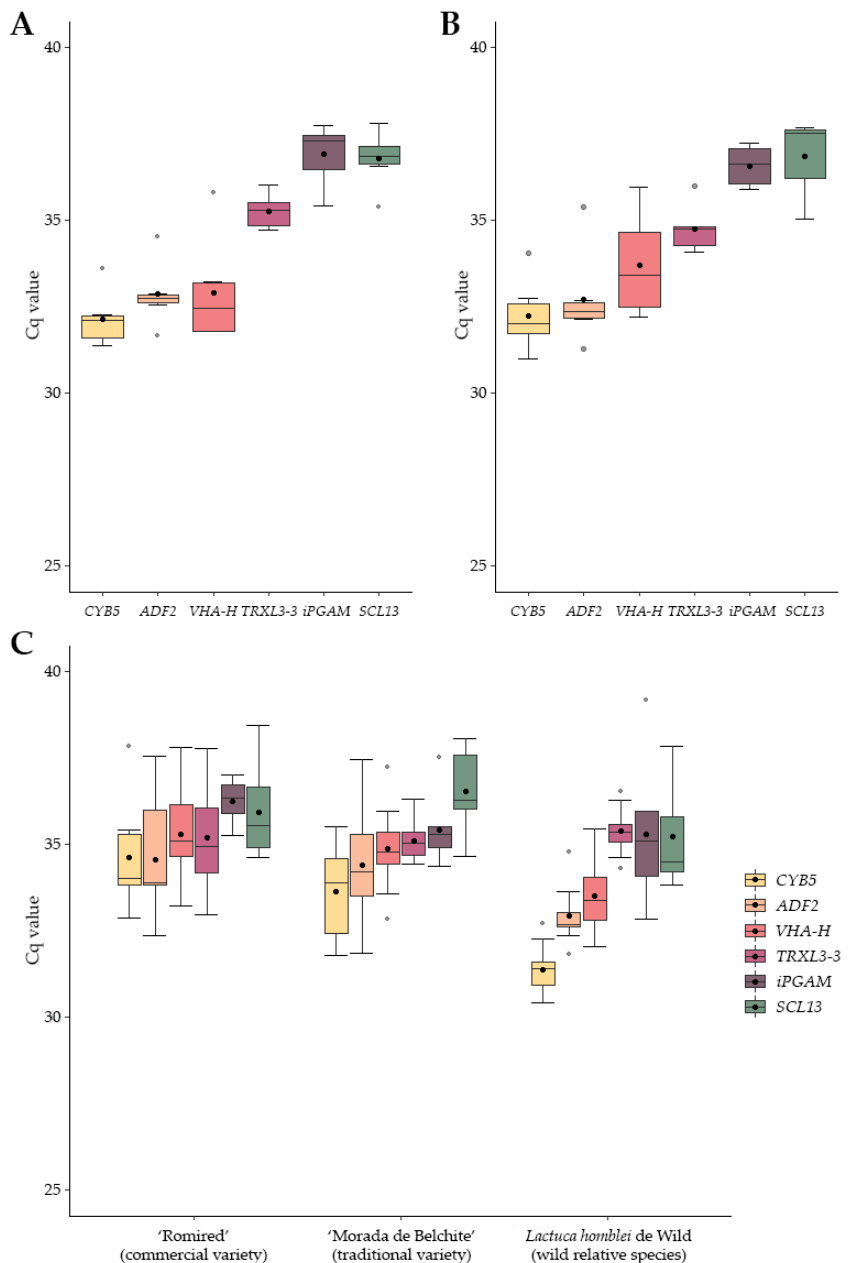
Figure 1. Expression levels, Cq (quantification cycle) values assessed by real-time qPCR (quantitative PCR), of six tested candidate RGs across the samples in three experiments: ( A ) comparison of leaf colour in green and red lettuce commercial varieties; ( B ) comparison of tissues (leaf and stem) in a wild relative species; and ( C ) drought stress in a commercial variety, a traditional variety, and a wild relative species. Lower and upper ends of the boxes represent the 25th and 75th percentiles, respectively, and whisker caps indicate the minimum and maximum values. Horizontal bars and black and grey dots depict the median, mean and outliers, respectively.